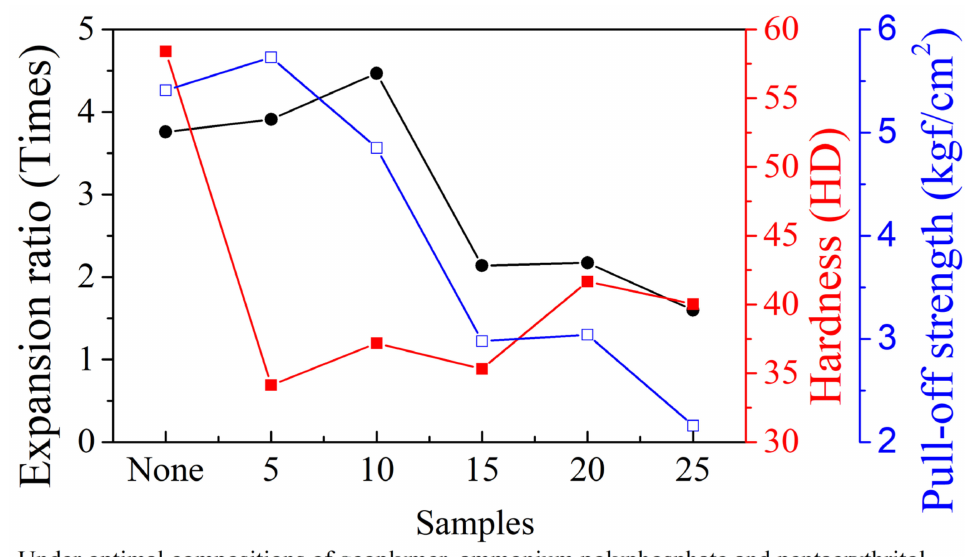
Figure 9. Physical properties of intumescent flame-resistant coatings after flame testing with optimal ratio of sodium silicate, ammonium polyphosphate, pentaerythritol and various contents of Al(OH) 3